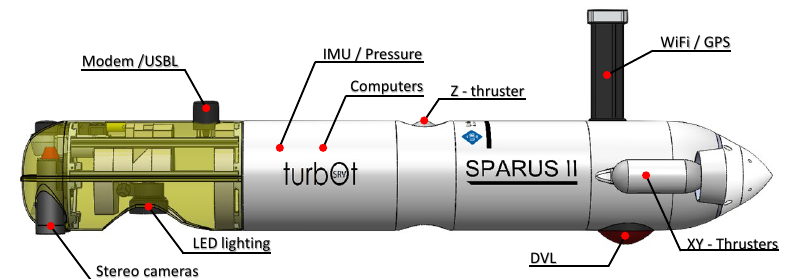
Figure 14. SPARUS II AUV.